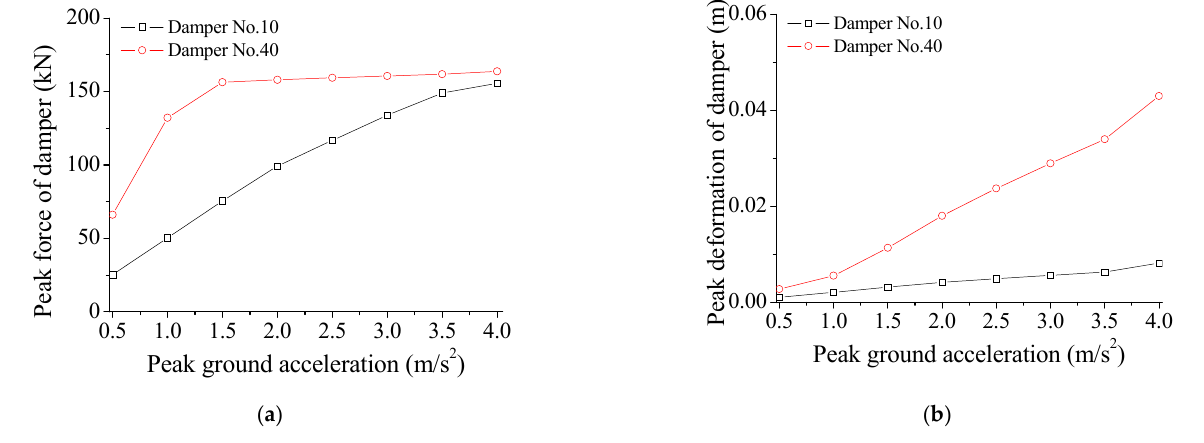
Figure 13. Variation of peak control force of SMA dampers with PGA. ( a ) Peak force; ( b ) Peak deformation.